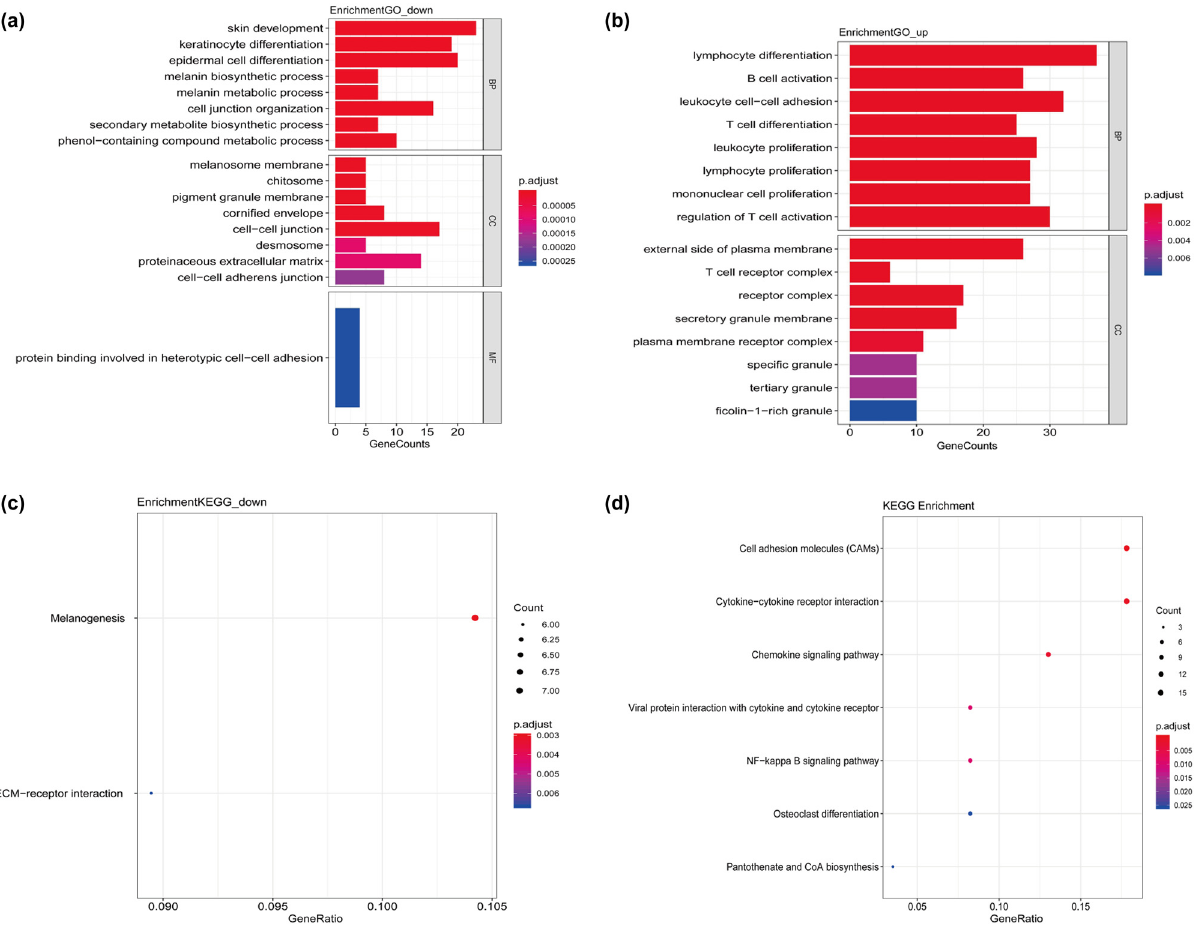
Figure 2: GO and KEGG enrichment analyses of di ff erentially expressed genes. ( a ) GO analysis results of the downregulated DEGs. ( b ) GO analysis results of the upregulated DEGs. ( c ) KEGG analysis results of the downregulated DEGs. ( d ) KEGG analysis results of the upregulated